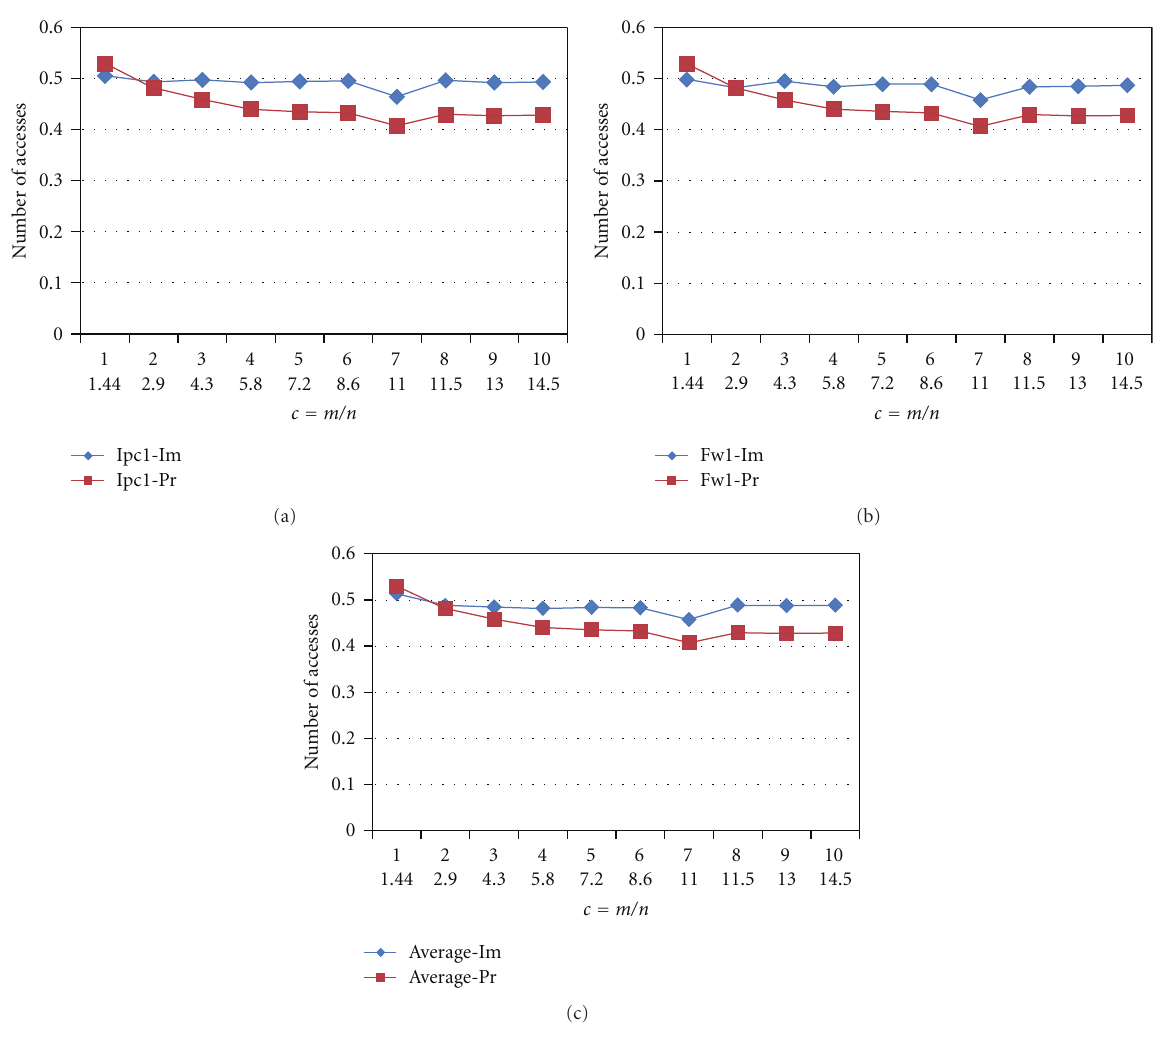
Figure 7: The number of accesses in CCBF normalized to the number of accesses in standard Bloom filter includes mathematical analysis and software implementation. (a) The number of accesses in a 3-level CCBF for Ipc1. (b) The number of accesses in a 3-level CCBF for Fw1. (c) The average number of accesses in a 3-level CCBF for all of the utilized rule-set databases in Table 1.